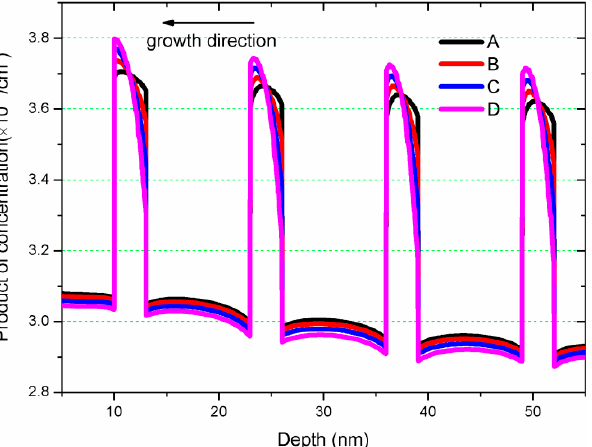
Figure 5. Comparison of electron-hole concentration product in InGaN QWs for samples A , B , C and D